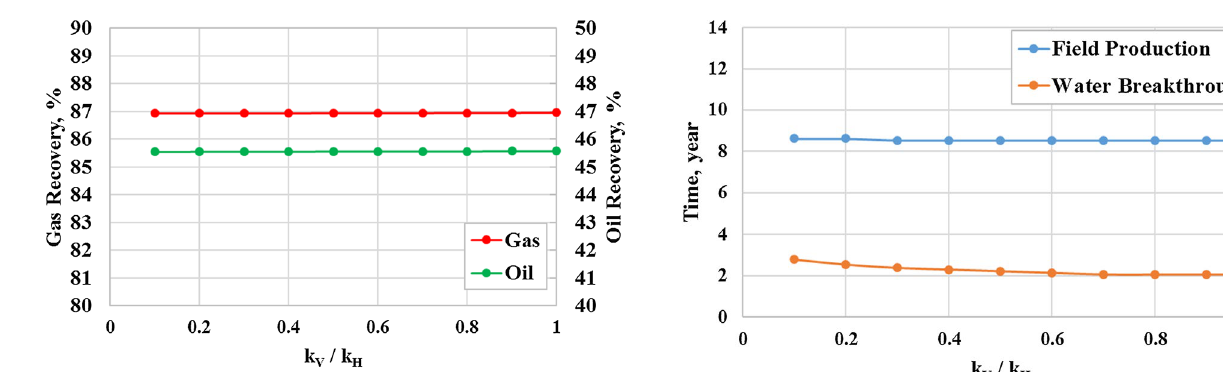
Fig. 35 Field production life and water breakthrough time for differ- ent vertical-to-horizontal permeability